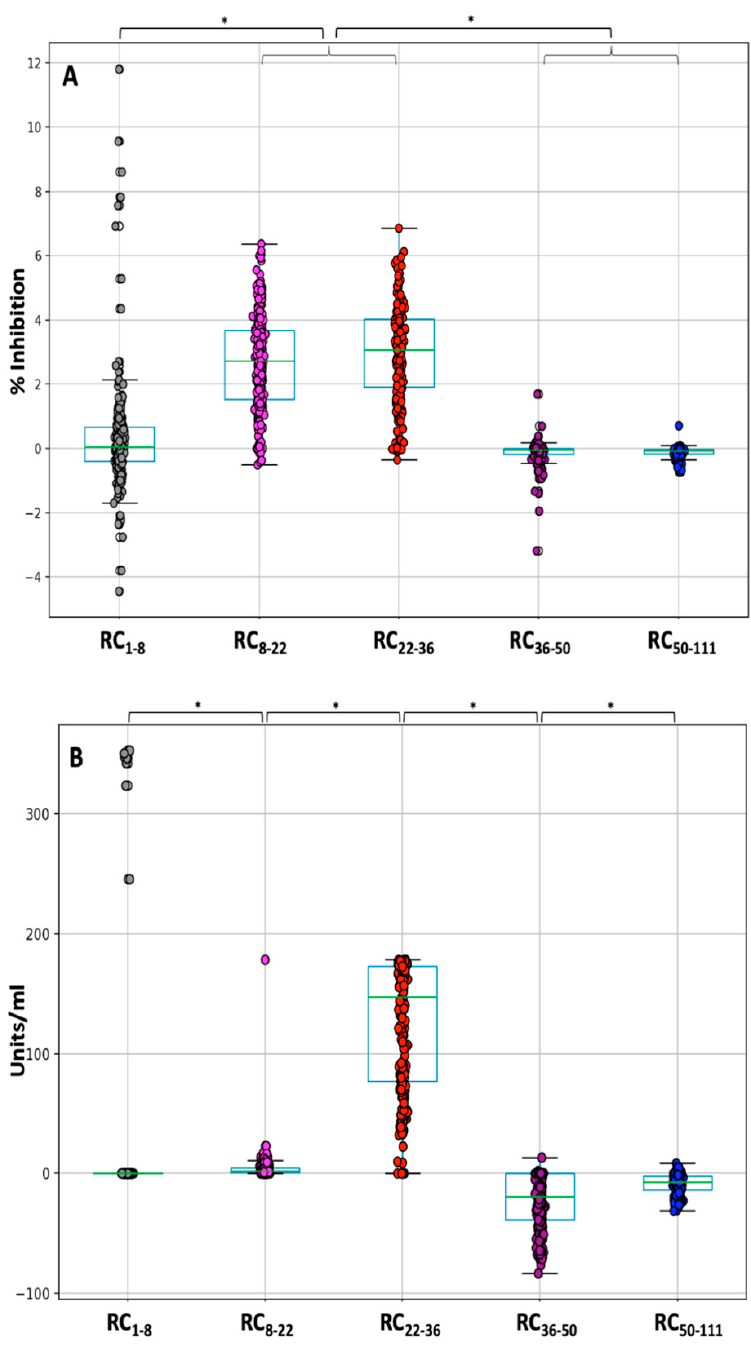
Figure 2. Rate of change in the (%) inhibition of SARS-CoV-2 binding to the human host receptor angiotensin-converting enzyme-2 ( A ) and anti-SRBD levels ( B ) after vaccination with the BNT162b2 mRNA vaccine. Rate of change (RC) values express the average change of antibody titers between two occasions and were estimated for two subsequent time points: RC 1–8 , RC 8–22 , RC 22–36 , RC 36–50 , RC 50–111 . Positive values indicate an increase in inhibition, negative values imply a decrease, and values close to zero show no change in the (%) inhibition of SARS-CoV-2 binding. Asterisks (*) indicate statistically significant differences ( p -value < 0.05) between the compared